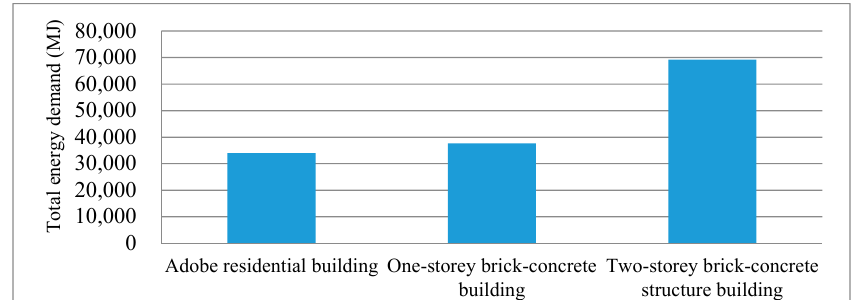
Figure 12. Total energy demand in the process of building demolition.